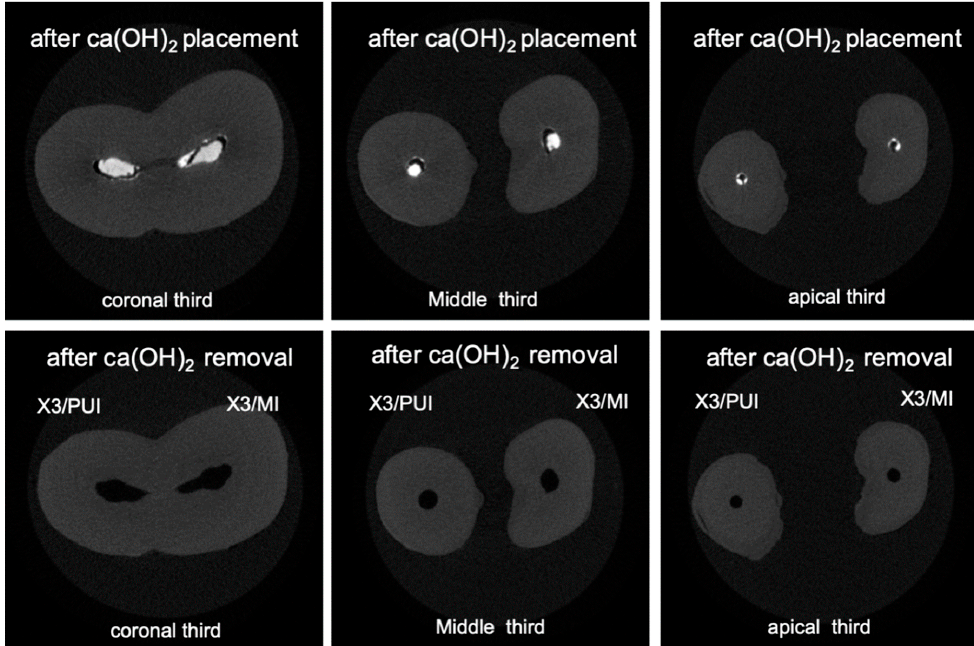
Figure 4. Cross-sectional micro-CT images of slices from coronal, middle, and apical thirds obtained before and after Ca(OH) 2 removal. Top images represent cross-sections from different levels of the root canals after the placement of Ca(OH) 2 . Bottom images represent cross-sections from different levels of the root canals after the placement of Ca(OH) 2 .